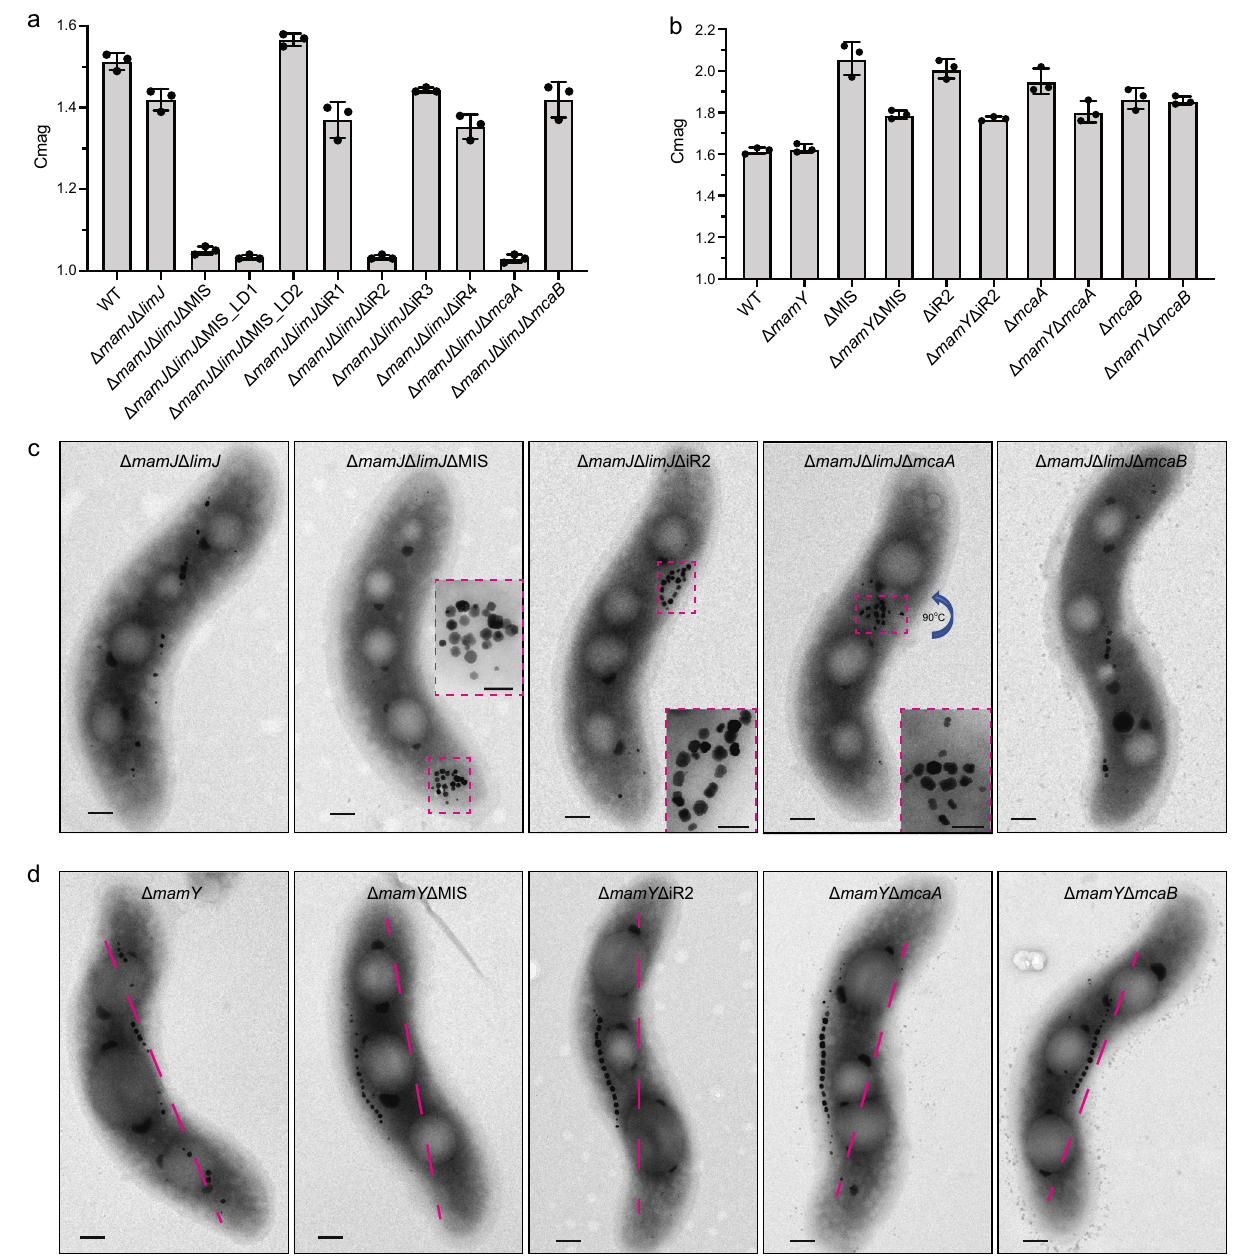
Δ mamJ Δ limJ Δ macAB ), Δ mamJ Δ limJ Δ mcaA , and Δ mamJ Δ limJ Δ mcaB cells. Scale bars=0.2 µ m.Insets: magni fi cation of the magneticcrystals in magentarectangles. Insets scale bars=100nm. d TEM micrographs of Δ mamY , Δ mamY Δ MIS, Δ mamY- Δ iR2 (also called Δ mamY Δ macAB ), Δ mamY Δ mcaA , and Δ mamY Δ mcaB cells. The magenta dashed lines indicate the positive inner curvature of AMB-1 cells where magnetosomes are normally located. Scale bars=0.2 µ